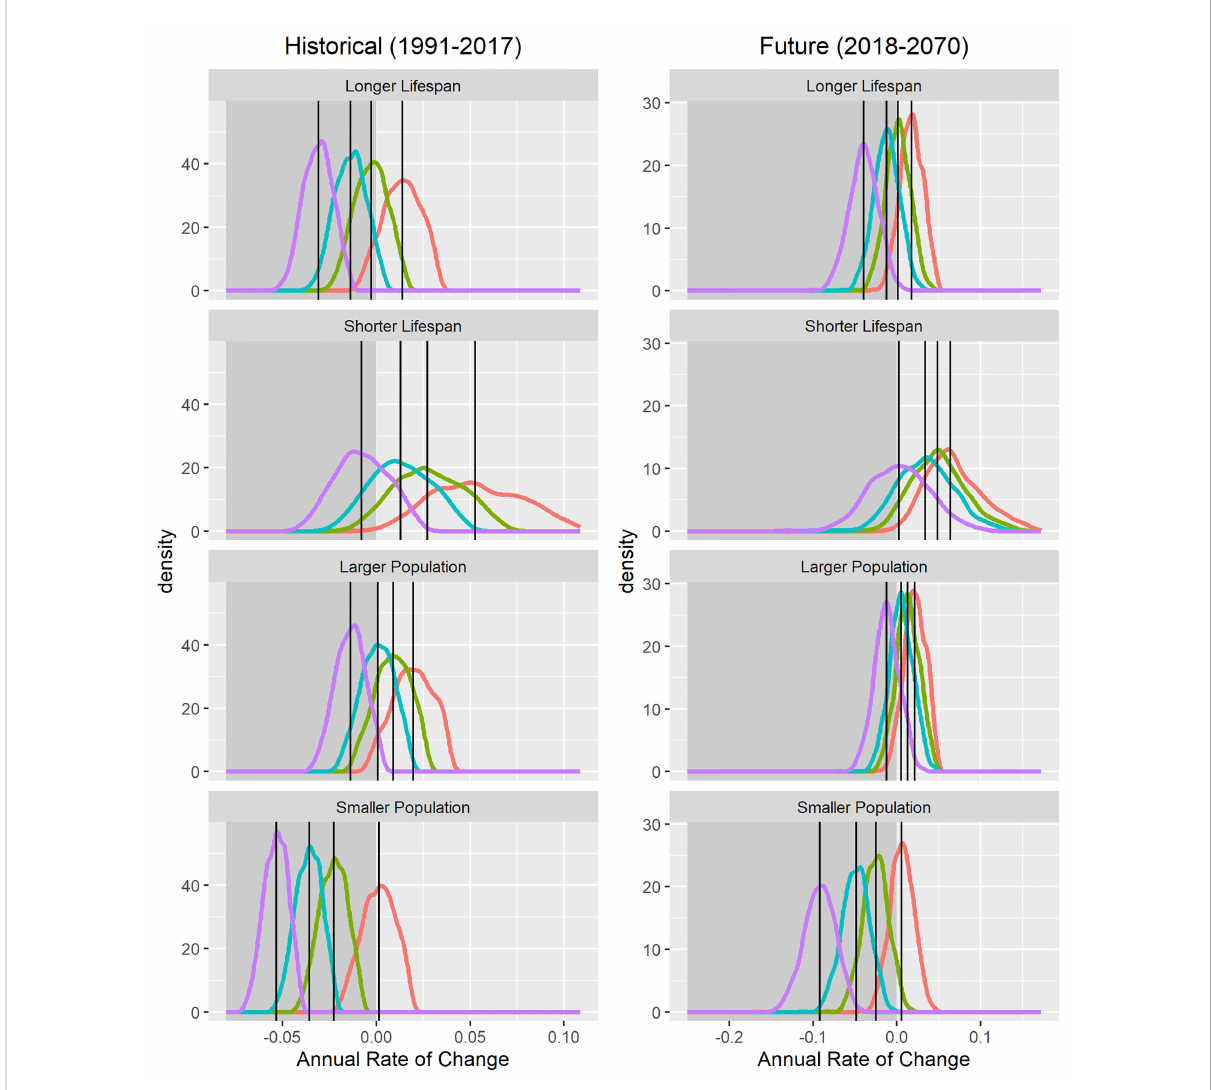
FIGURE 1 A comparison of the distribution of annual rates of abundance change from lognormal regression under four levels of removals: 10 (red lines), 30 (green lines), 50 (blue lines) and 100 (purple lines) animals per year in the backwards projections (left panels) and forwards projections (right panels) of the simulation model for four life history scenarios. The median of each distribution is identi fi ed by a vertical line and the dark grey shading identi fi es values < 0 (indicative of abundance